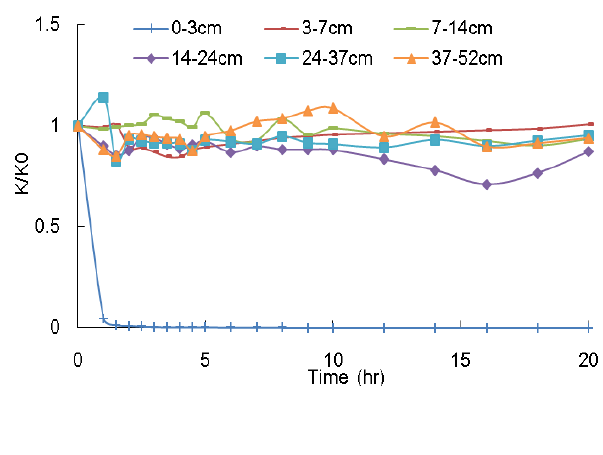
Figure 5. Total suspended solids (TSS) concentration of inflow and outflow.